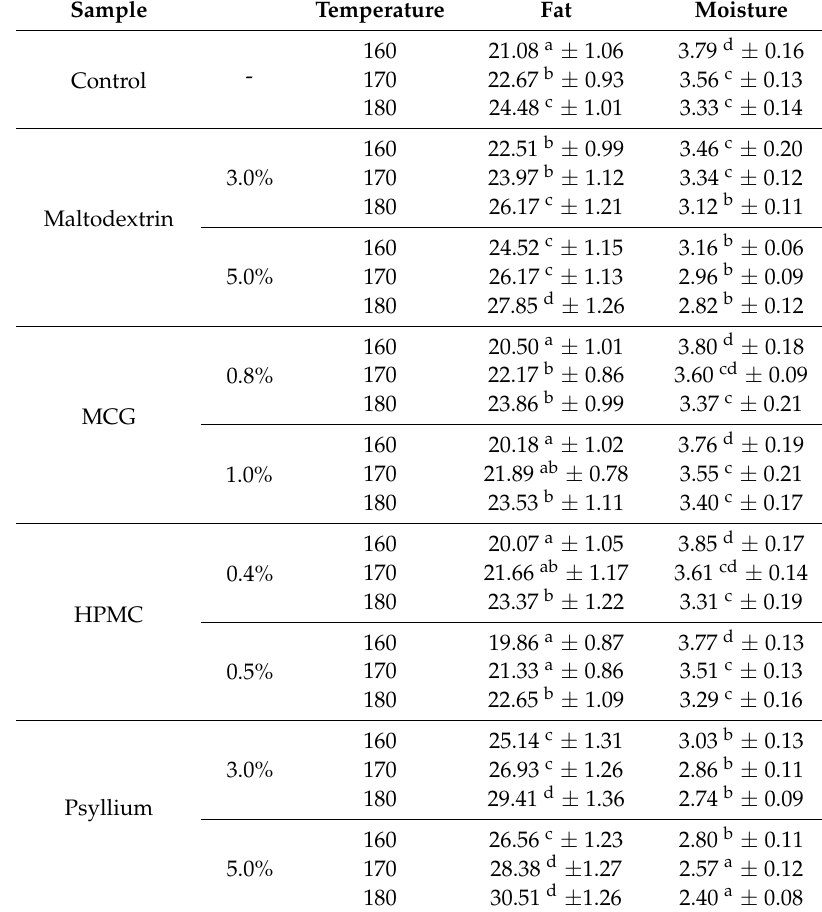
Table 1. The effect of the addition of hydroxypropylmethylcellulose (HPMC), microcrystalline cellulose (MCG), maltodextrin, and psyllium on the moisture and oil uptake in fried instant